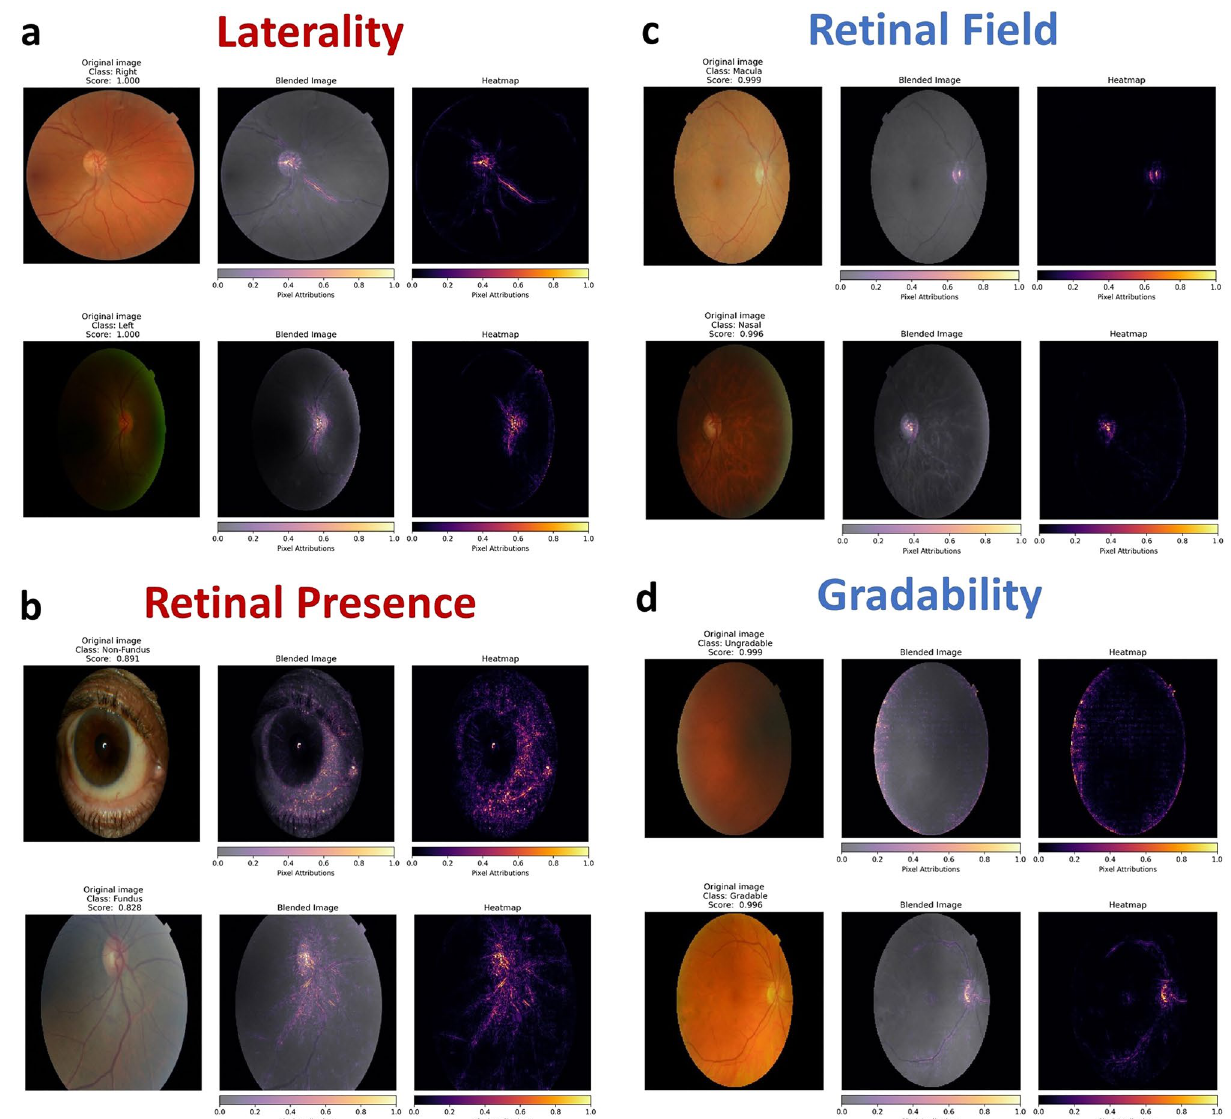
Figure 5. Internal test single-output model pixel attribution maps. Integrated gradients pixel attributions: all models highlight the optic cup/disc within retinal images, especially model c. Models a, b and d also highlight the retinal vessels to varying degrees. Model b ( non-retinal image ) highlights the caruncle, lower tear meniscus, iris striations, conjunctival vessels, and corneal reflection. Model attributions relative to the true positive class in each